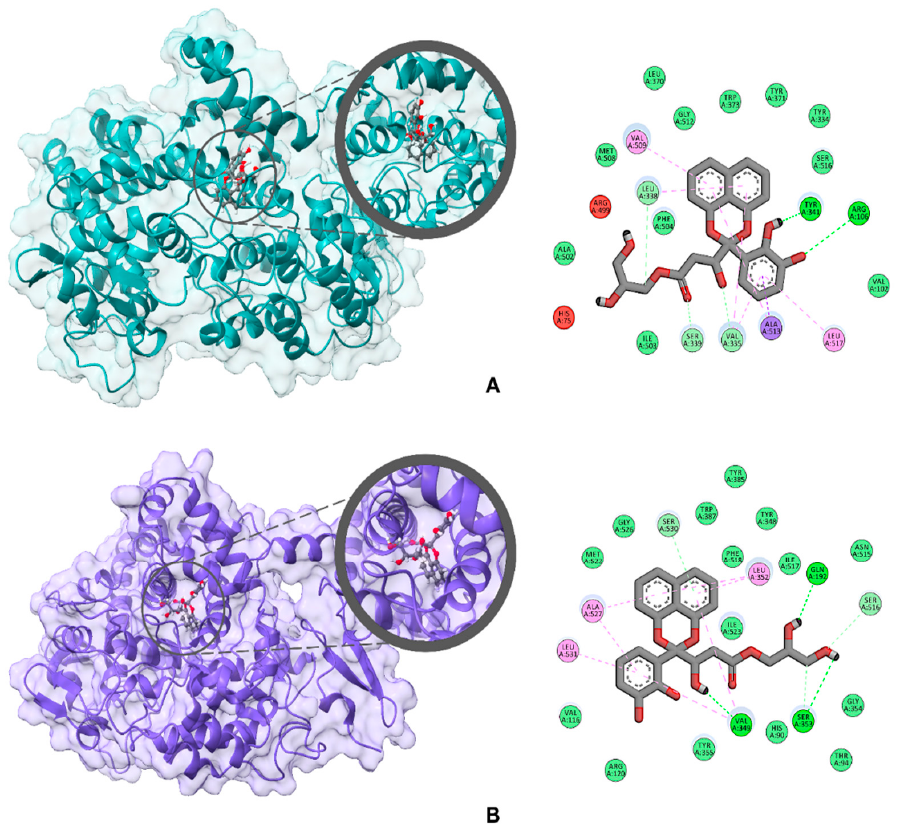
Figure 5. 3D and 2D docked poses of sparticatechol A (1) against ( A ) COX-2 (PDB ID: 3LN1) and ( B ) COX-1 (PDB ID: 3KK6).